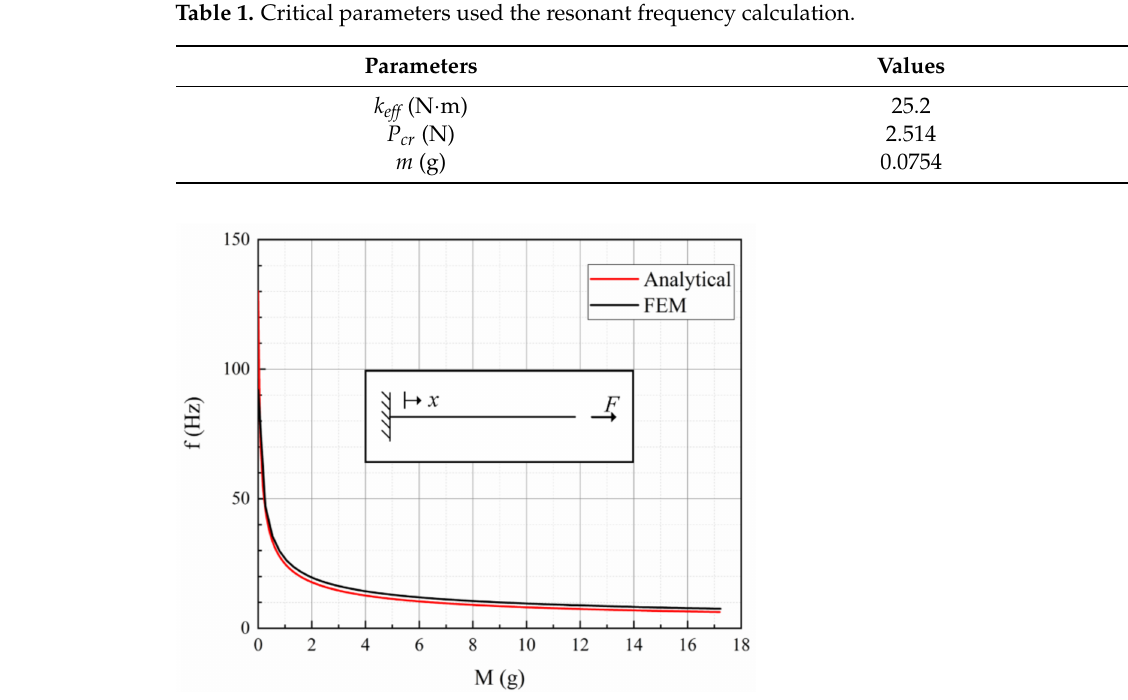
Figure 2. The fundamental resonant frequency versus the mass of the magnet. The computation is based on the values given in Table